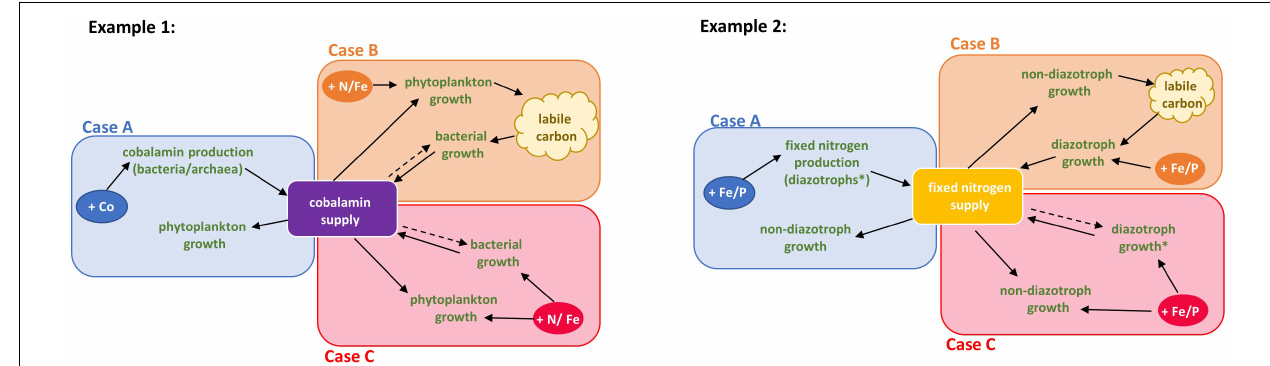
FIGURE 1 | Cases of community interaction co-limitation modeled with cobalamin and nitrogen fixation. Solid arrows indicate that an increase in the resource or process where the arrow originates facilitates the process or production of the resource that the arrow is pointed toward. Dashed arrows indicate a potential influence of an increase in the resource (origin of arrow) on the process which resulted in its production (arrowhead) and thereby indicates potential resource consumption and/or competition. Case A: Biological production of a nutrient is restricted by the availability of nutrients required for the production of that nutrients. Example 1: Cobalt availability restricts cobalamin synthesis by heterotrophic bacteria which in turn limits phytoplankton by cobalamin. Example 2: Iron or phosphorus availability restricts nitrogen fixation by diazotrophs which limits fixed nitrogen supply to non-diazotroph growth. Case B: Biological production of a nutrient is limited by a factor which is produced by the consumer of the biological nutrient. Example 1: Nitrogen and/or iron co-limit phytoplankton growth which restricts dissolved organic carbon availability, limiting heterotrophic bacterial growth. This low bacterial growth then limits cobalamin production leaving the community co-limited by nitrogen or iron and cobalamin. Example 2: Iron or phosphorus availability restricts nitrogen fixation by diazotrophs which limits fixed nitrogen supply to non-diazotroph growth. This could result in a (co-)limitation of diazotrophs by DOC. Case C: Producers and consumers are limited by the same resource which further inhibits the biological production of a nutrient required by the consumers. Example 1: Both phytoplankton and heterotrophic bacteria are limited by iron (or another resource), which restricts cobalamin synthesis and could results in co-limitation of phytoplankton by cobalamin and iron. Example 2: Both diazotrophs or non-diazotrophs are limited by iron or phosphorus that constrains fixed nitrogen production which co-limits non-diazotrophs growth. *The diazotroph part of the community here could also represent or include close association between a diazotroph and an autotroph exchanging